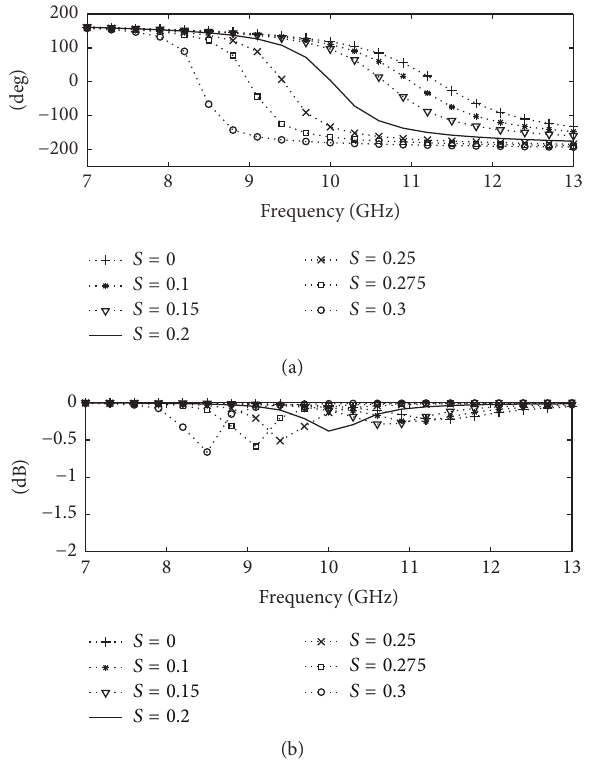
Figure 14: (a) Phase and (b) amplitude of the simulated reflection coefficient versus frequency for different value of the scaling factor 𝑆 (1st iteration fractal unit cell with 𝐿 = 7.6 mm and Δ𝑥 × Δ𝑦 = × 0.3𝜆 0.3𝜆 0 0 ).